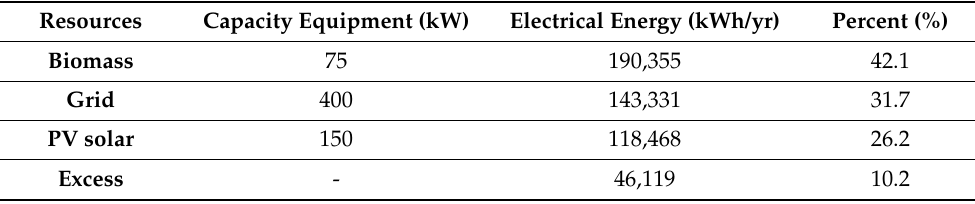
Table 1. Optimal component capacity configured by HOMER